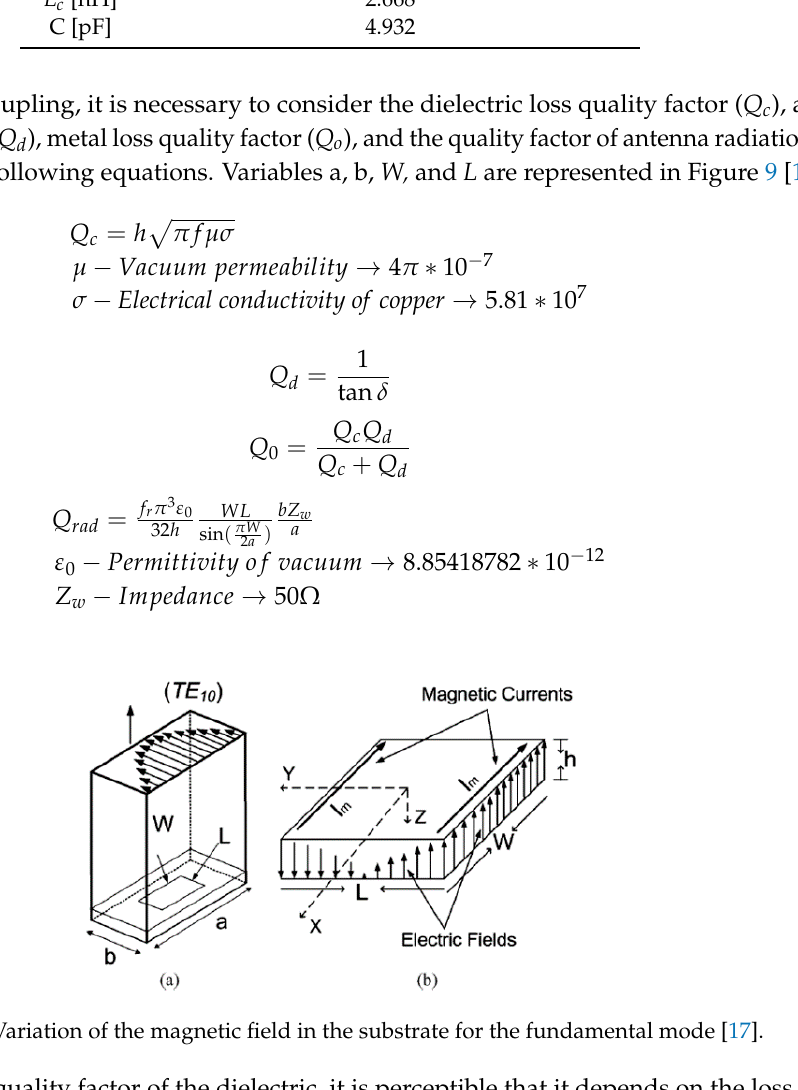
Table 6 . Values obtained from the RLC equivalent circuit.